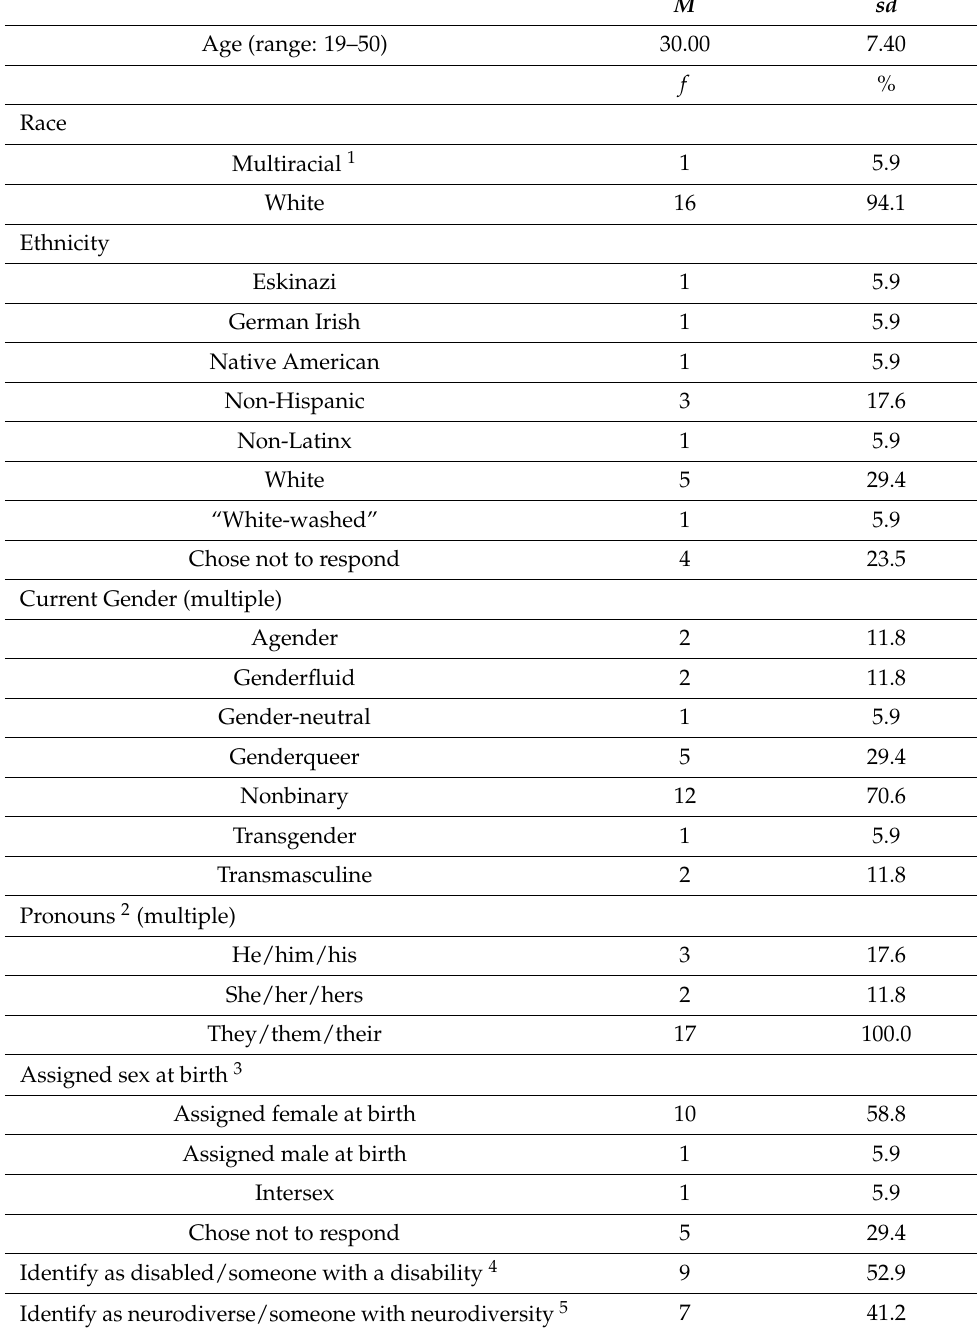
Table 1. Participant Researcher Demographics ( N =